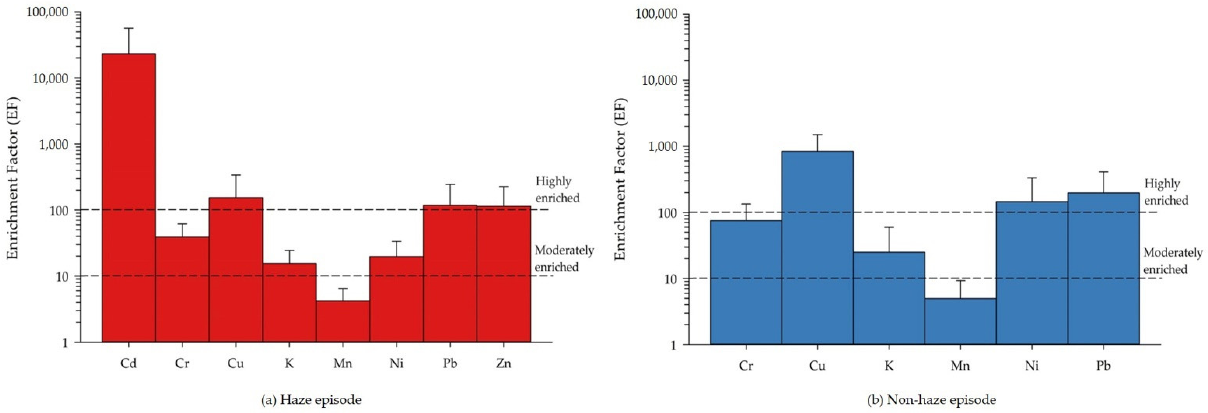
Figure 2. The average enrichment factor of element in PM 2.5 during haze episode and non-haze episode.